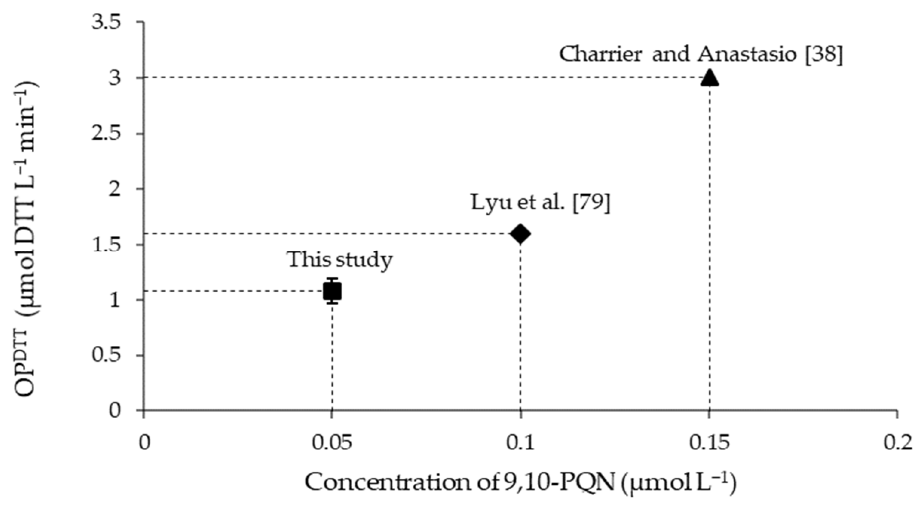
Figure A1. OP DTT blank-corrected for 9,10-PQN used as a positive control: the concentration of 9,10-PQN is 0.05 µ mol L − 1 in this study, 0.1 µ mol L − 1 in Lyu et al. [79], and 0.15 µ mol L − 1 in Charrier and Anastasio [38].